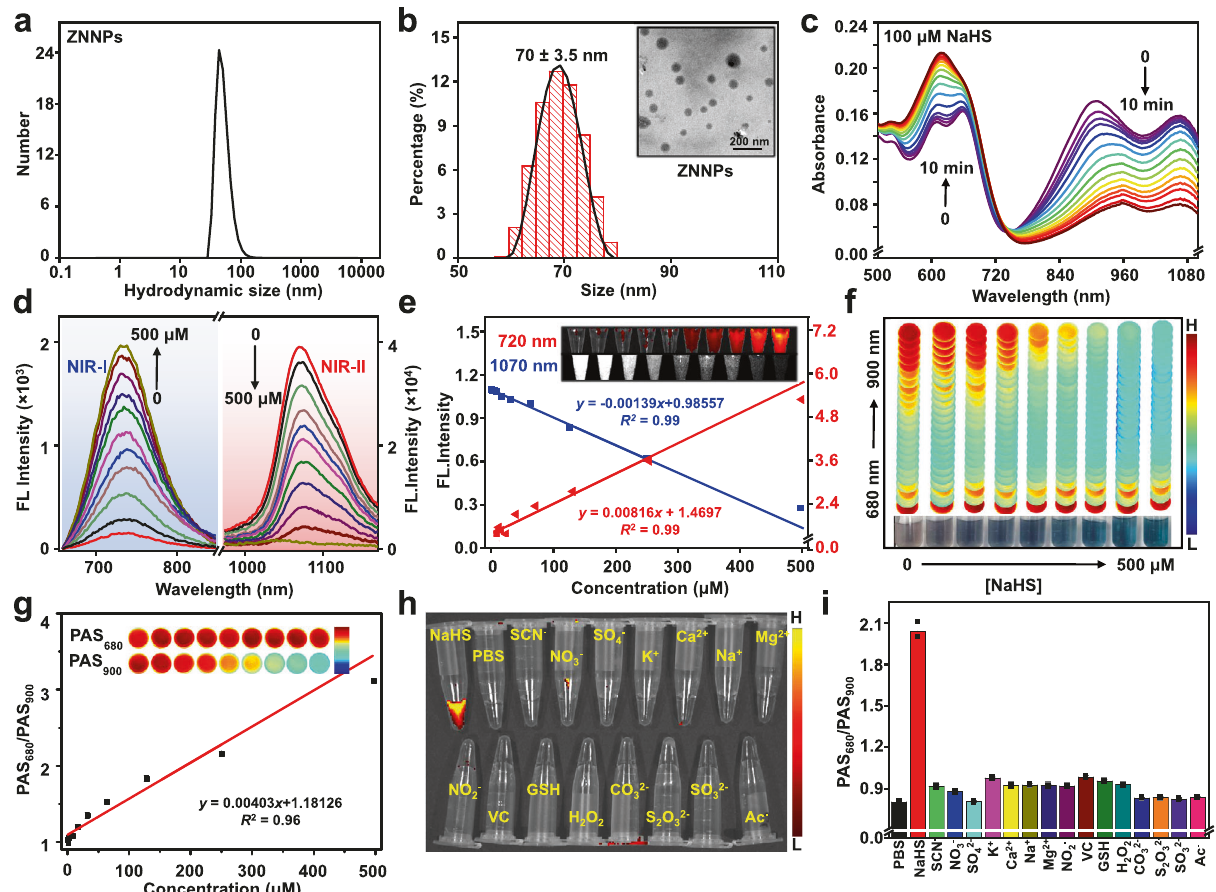
Fig. 2 Characterization and H 2 S speci fi city of ZNNPs in PBS buffer. a DLS data of ZNNPs in PBS buffer (pH = 7.4). b TEM image and size distribution of ZNNPs. c Normalized absorption of ZNNPs (14 μ g/mL) upon incubation with NaHS (100 μ M) at R.T. for 10 min. d Fluorescence spectra and e linear fi tting of fl uorescence intensity of ZNNPs (14 μ g/mL) with various concentrations of NaHS ranging from 0 to 500 μ M at R.T. for 10 min (Right axis: 1070 nm, Left axis: 720 nm). f Photoacoustic signal pro fi les and g linear fi tting of PAS intensity of ZNNPs (14 μ g/mL) with various concentrations of NaHS ranging from 0 to 500 μ M at R.T. for 10 min. h Fluorescence images and i ratiometric photoacoustic signals (PAS 680 /PAS 900 ) of ZNNPs (14 μ g/mL) incubated with different biological species (PBS buffer, 100 µ M NaHS, 1 mM SCN − , 1 mM NO 3 − , 1 mM SO 4 2 − , 1 mM K + , 1 mM Ca 2 + , 1 mM Na + , 1 mM Mg 2 + , 1 mM NO 2 − , s.d. ( n = 3 independent samples). Source data are provided as a Source Data fi